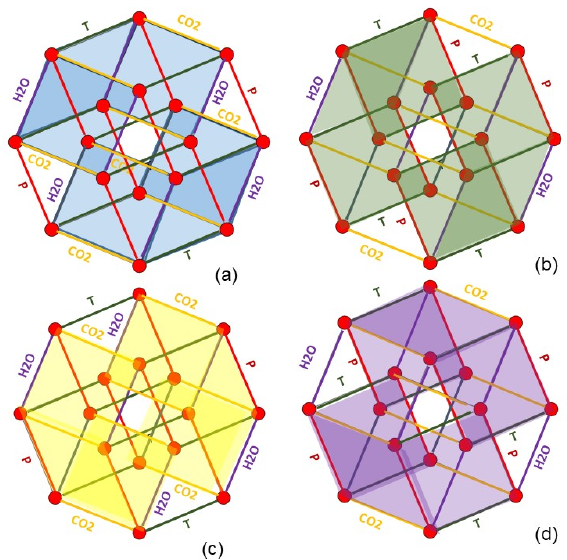
Figure 13. Tesseract (Coxeter B4 projection) showing the four (color-coded) possible initial three interpolation routes for {%Gas _1 in Gas_ 2 } concentration vs. sound velocity polynomial fit param- eters within the 4-D {P,CO 2 ,T,H 2 O} database ( a – d ): respectively via the {CO 2 ,H 2 O,T}, {T,H 2 O,P}, {CO 2 ,P,H 2 O}, and {CO 2 ,P,T} pathways.